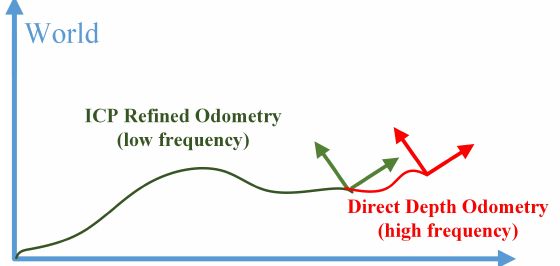
Figure 4. Illustration of transform integration. The green segment represents transforms published by the ICP refined odometry at a low frequency, regarding sensor poses in the world coordinate system. The red segment represents transforms published by the direct depth odometry at a high frequency. The two transforms are integrated to generate high frequency sensor pose outputs at the depth image frame